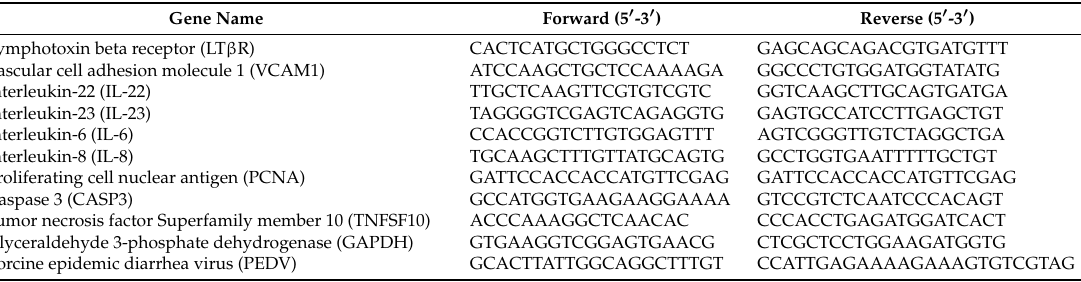
Table 1. Primers used in this